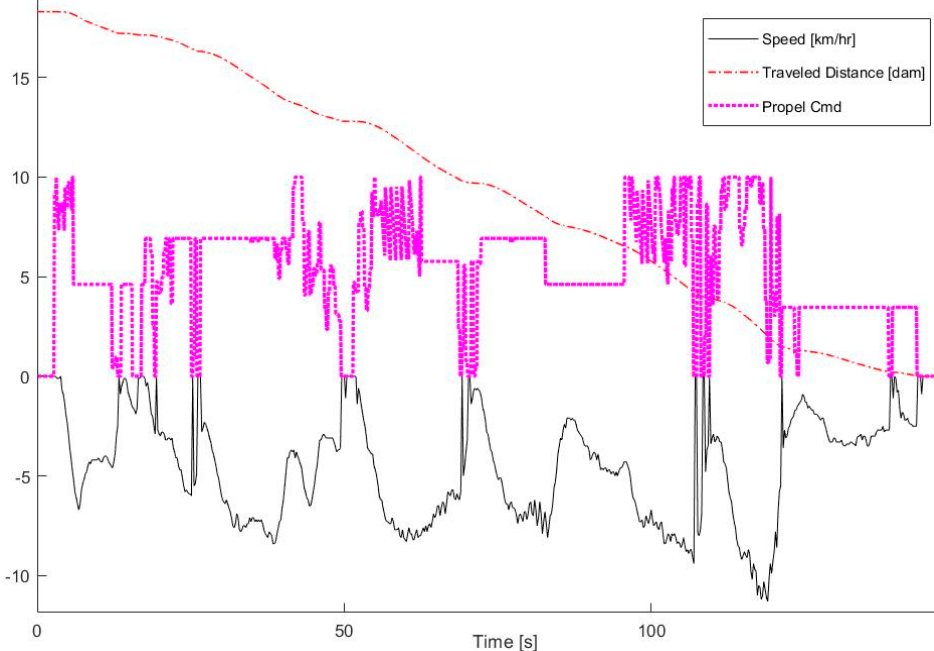
Figure 19. Autonomous System propel commands and LHD speed on dataset 14.